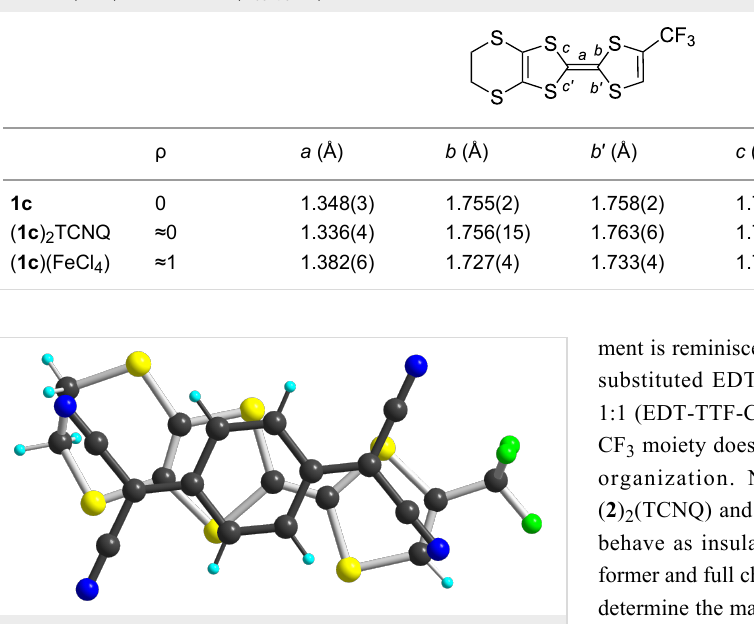
Table 5: Structural characteristics of the C 2 S 4 central core in EDT-TTF-CF 3 ( 1c ) derivatives. ρ is the charge of 1c in the different combinations. Bonds a (C=C) and b , b ′ , c , c ′ (C central − S) are identified in the scheme below.